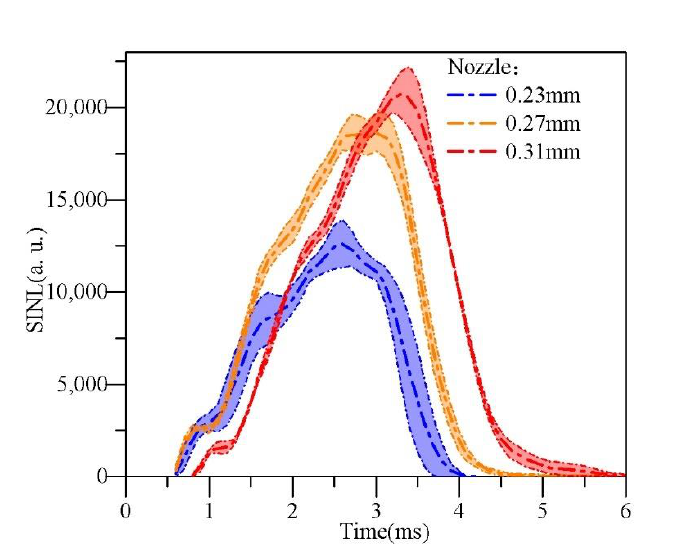
Figure 16. Flame spatially integral natural luminosity (SINL).